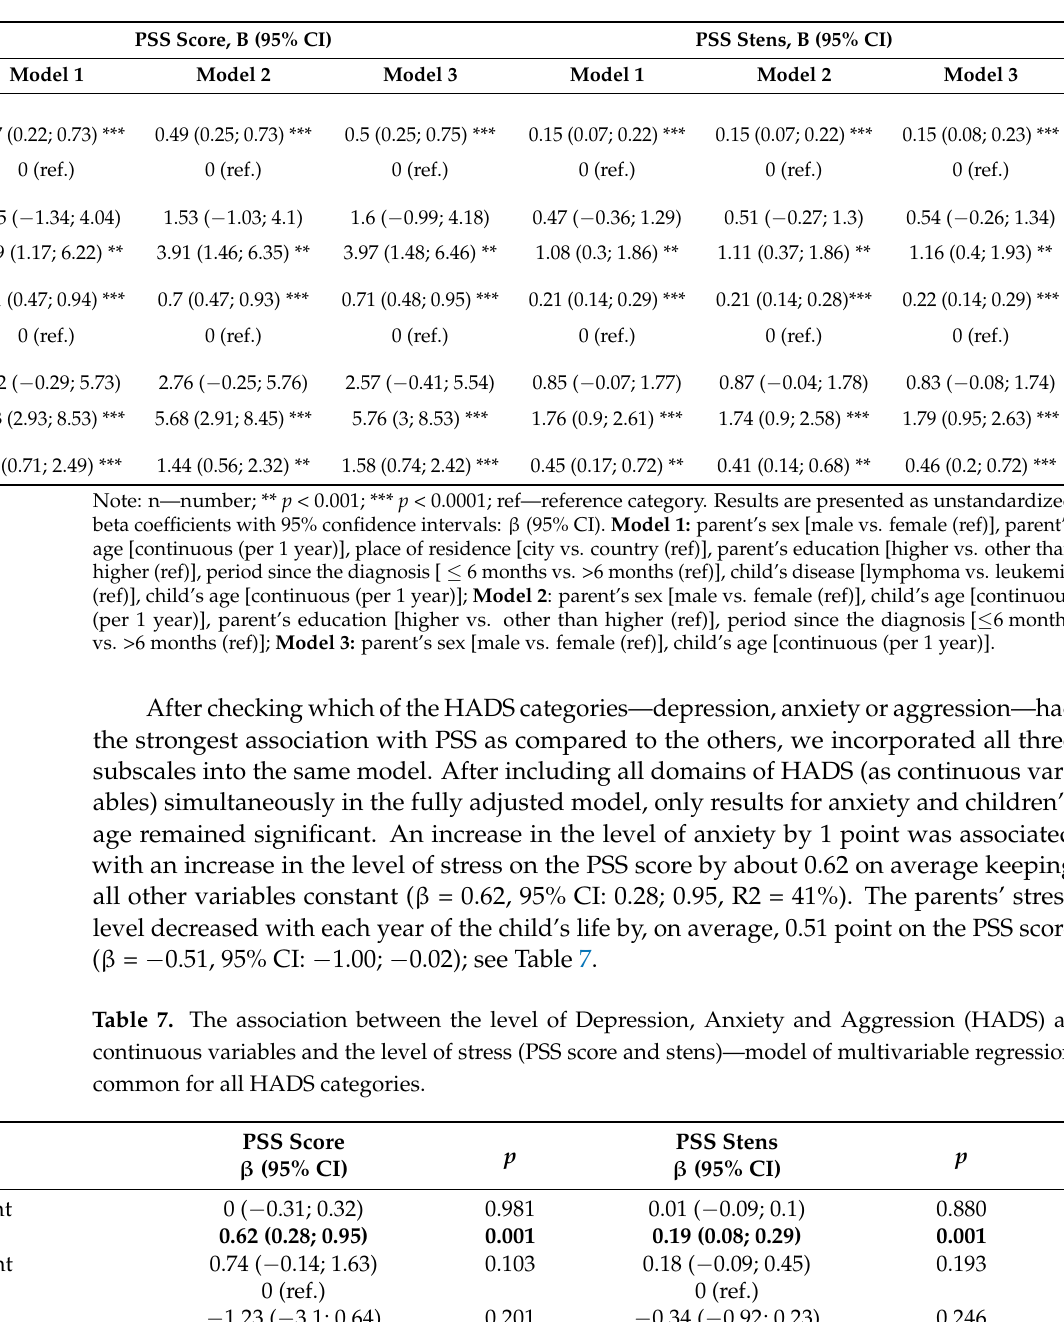
Table 6. Relationship between depression, anxiety and aggression (as continuous variables and in subcategories) and the level of stress in parents—separate models of multivariable regression for each HADS category.